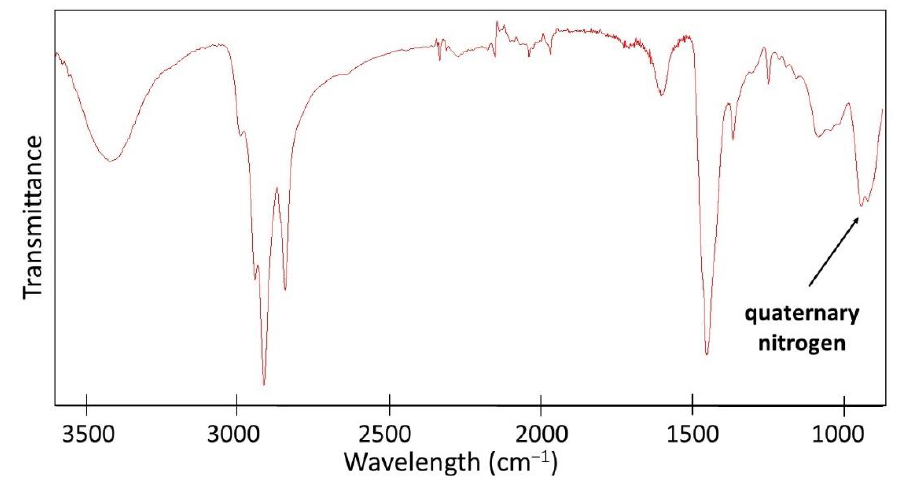
Figure 5. The ATR-FTIR spectra of QA-PEI-NPs. The dimensions of the QA-PEI-NPs were analyzed utilizing the DLS technique (Figure 6). Three fractions of particles were detected with an average size of (i) 151 nm ( ± 28 nm) that constituted 18.9% of all particles, (ii) 732 nm ( ± 222 nm) that constituted 73.9% of all particles, and (iii) 5212 nm ( ± 467 nm) that constituted 7.2% of all nanoparticles. The Z-average size was 509.1